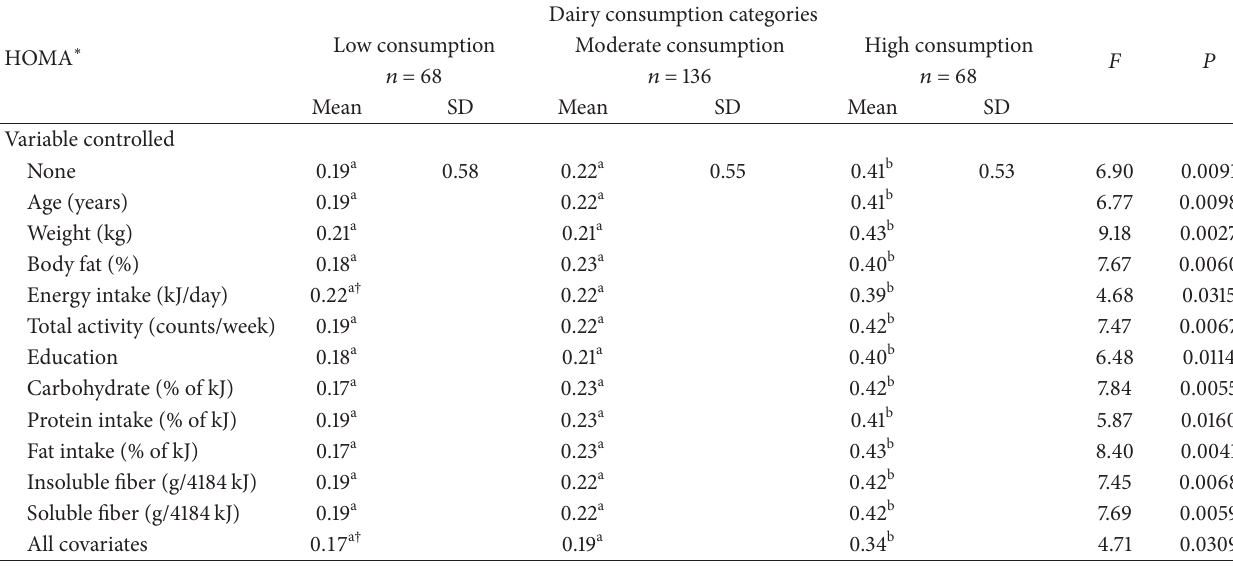
Table 3: Mean differences in HOMA by the dairy intake categories, without and with adjustment for the potential confounders. Dairy consumption categories Low HOMA ∗